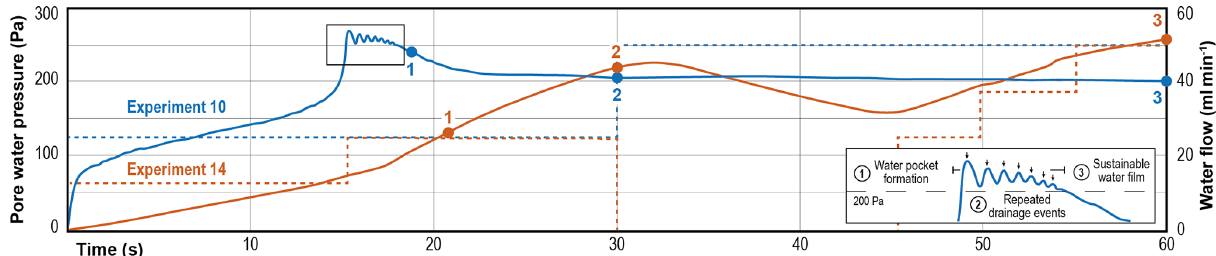
Figure 4. Evolution of pore water pressure (solid lines) measured in the trunk axis (see Fig. 5a for position) and water flow injected in the bed through the water injector (dotted lines), for experiments 10 and 14. Points numbered 1 to 3 correspond to stages described in Sect. 4.1, 4.2 and